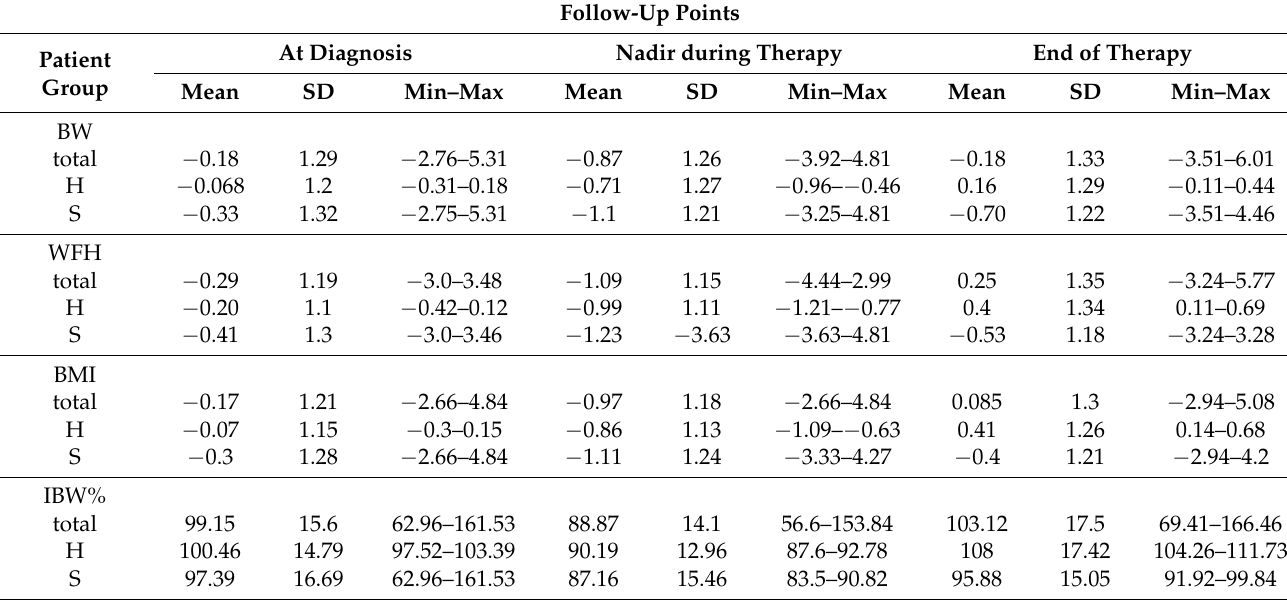
Table 2. Changes in mean values of body weight, weight-for-height, body mass index Z-scores, and ideal body weight percentage at three follow-up time points.